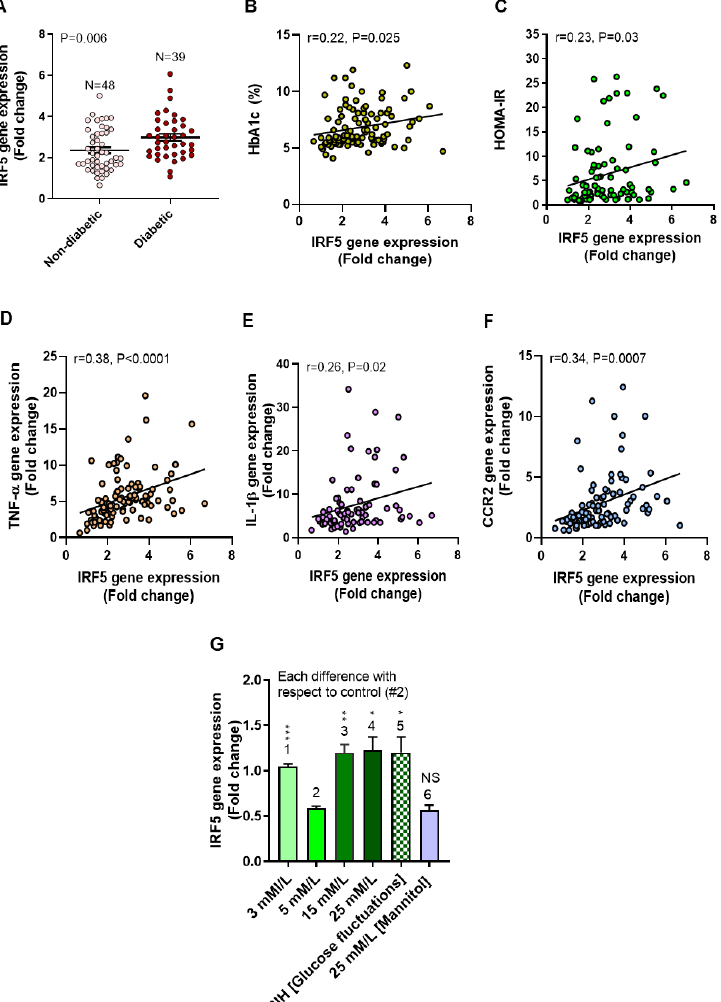
Figure 1. Adipose IRF5 gene expression is upregulated in type-2 diabetic patients as well as in macrophages cultured under low, high, and repetitive intermittent hyperglycemia (RIH). Adipose tissue samples from nondiabetic (N = 48) and diabetic (N = 39) individuals were analyzed for transcripts of interferon regulatory factor (IRF5), tumor necrosis factor (TNF)- α , interleukin (IL)-1 β , and C-C motif chemokine receptor (CCR)-2 using real-time qRT-PCR as described in the Materials and Methods section. Glycated hemoglobin (HbA1c) levels were determent by biochemical analysis of whole blood samples. In addition, THP-1 monocytic cells were di ff erentiated into macrophages and cultured for 3 days under conditions of hypoglycemia (3 mM / L), normoglycemia (5 mM / L), persistent medium and strong hyperglycemia (15 mM / L and 25 mM / L, respectively), and RIH / glucose fluctuations (3–15 mM / L). Macrophages were cultured with mannitol (25 mM / L) for osmolar control. ( A ) Adipose IFR5 mRNA expression was found to be higher in diabetic than nondiabetic individuals ( p = 0.006). The increased adipose IRF5 expression correlated positively with ( B ) HbA1c (r = 0.47, p < 0.0001), ( C ) Homeostatic Model Assessment of Insulin Resistance (HOMA-IR) (r = 0.23, p = 0.03), ( D ) TNF- α (r = 0.56, p < 0.0001), ( E ) IL-1 β (r = 0.40, p = 0.0009), and ( F ) CCR2 (r = 0.49, p < 0.0001). ( G ) IRF5 gene expression was upregulated in THP-1 macrophages following exposure to hypoglycemia, persistent medium and strong hyperglycemia, and RIH / glucose fluctuations as compared to control (normoglycemia). All data are expressed as mean ± SEM values. * p ≤ 0.05, ** p ≤ 0.01, *** p ≤ 0.001, and NS: